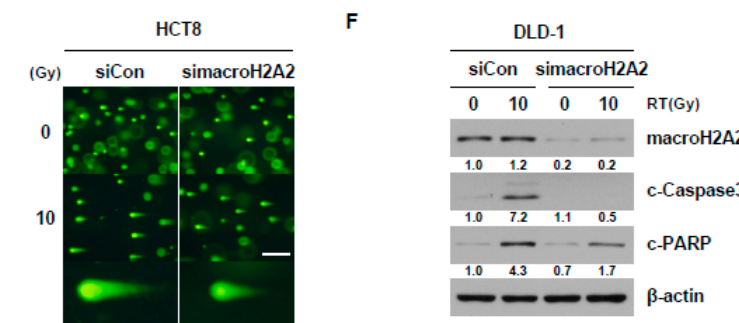
Figure 5. The reduction in macroH2A2 caused by 15-LOX-1 transcriptional downregulation is involved in radioresistance through reduction of the radiation response. ( A ) The downregulation of UV-RESPONSE_UP was observed by microarray data. (NOM p -value < 0.001, FDR q -value: 0.29, NES: − 1.22) ( B ) Increased γ H2AX expression in stable cell lines with time. ( C ) We incubated DLD-1 cells for 24 h after simacroH2A2 transfection. The transfected cells were irradiated at 10 Gy, and the formation of γ H2AX foci was analyzed 24 h after irradiation. Scale bar, 10 µ m. ( D ) A DNA fragmentation assay was conducted after transfection with simacroH2A2. ( E ) Comet assay results were visualized by using epifluorescence microscopy 24 h after irradiation. Scale bar, 200 µ m. ( F ) Attenuation of IR-induced apoptotic cell death by simacroH2A2 in DLD-1 cells.